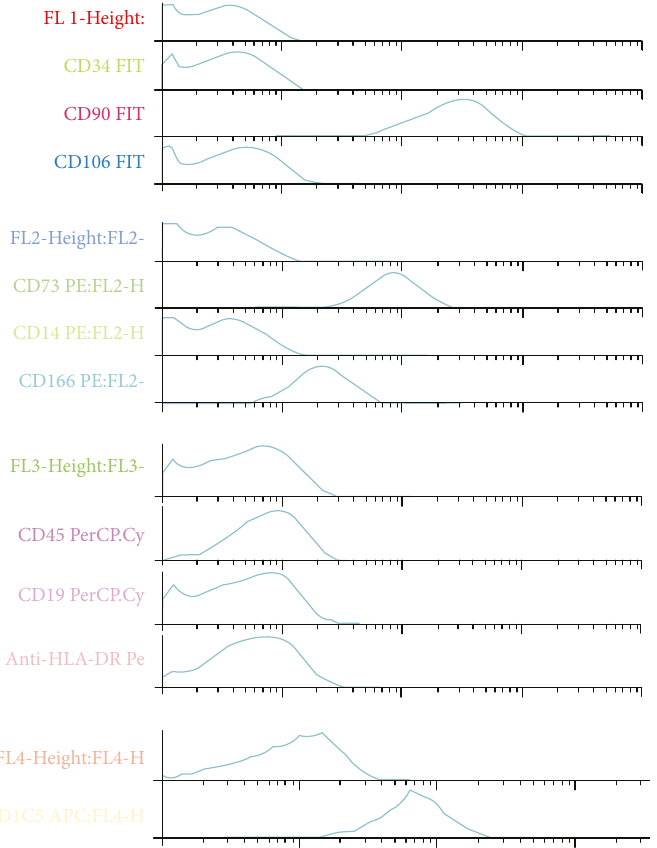
Figure 2: Immunophenotypic pro fi le by fl ow